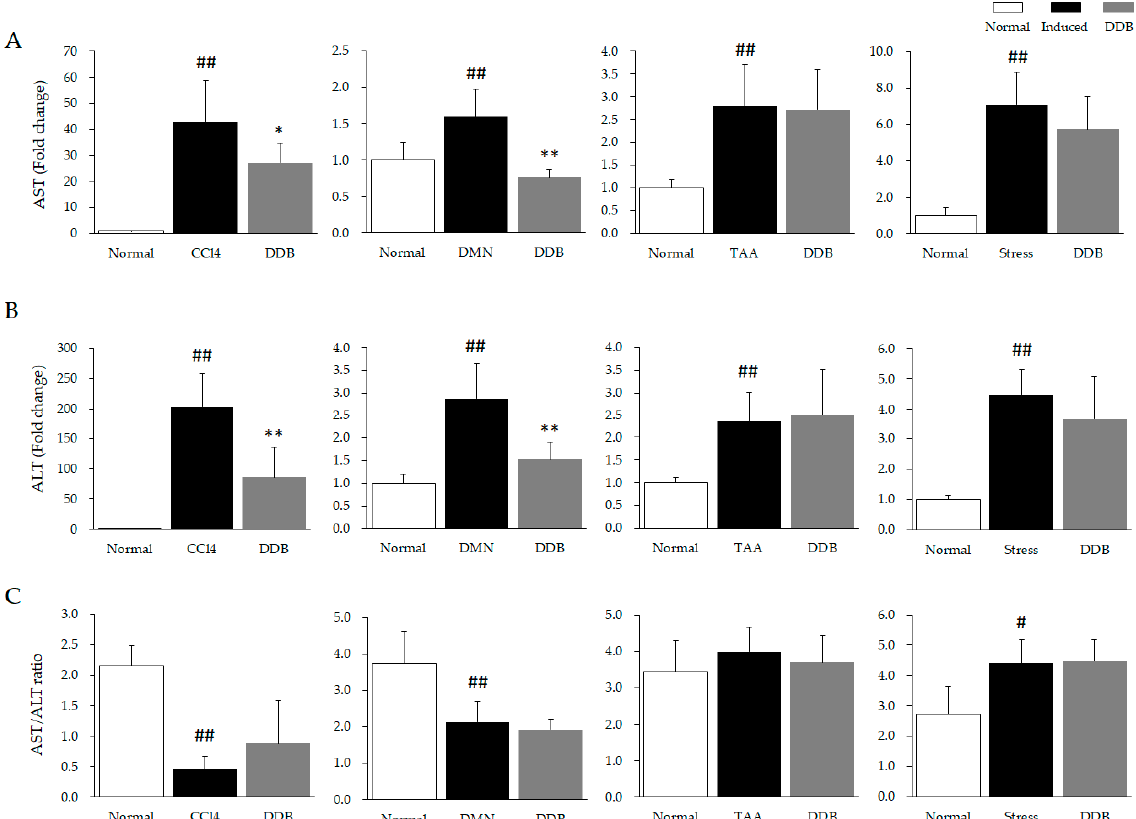
Figure 2. Comparison of serum aminotransferases and the AST/ALT ratio in four liver injury models. Serum AST ( A ) and ALT ( B ) levels from four types of liver injury models were examined by an AU480 chemistry analyzer, and the AST/ALT ratios ( C ) were calculated and horizontally compared. # p < 0.05 and ## p < 0.01 compared with the normal group. * p < 0.05 and ** p < 0.01 compared with the corresponding control.